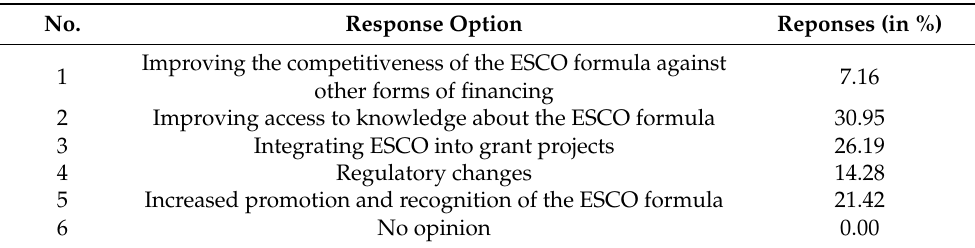
Table 4. Activities to increase interest in ESCO projects. Source: CAWI